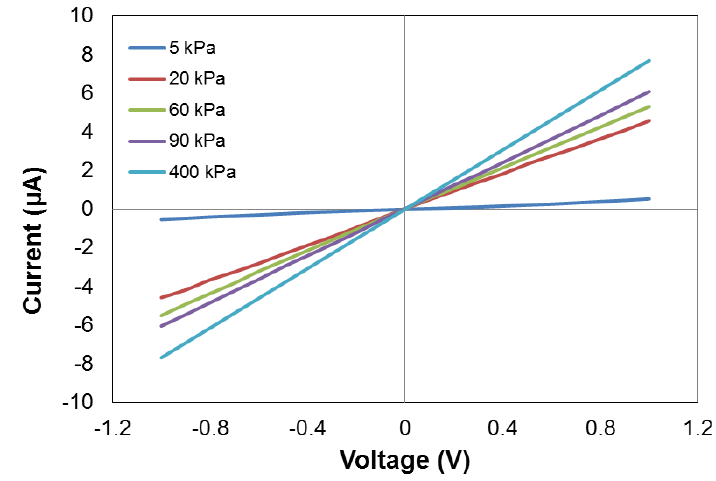
Figure 6. Current-voltage (I–V) characteristics of the sensor under different applied